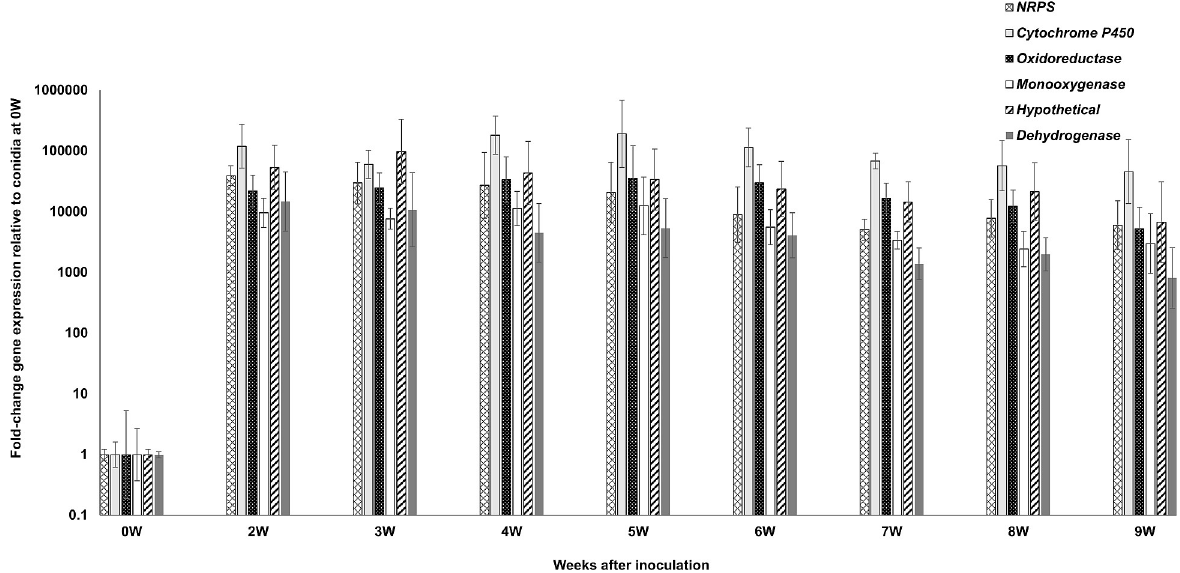
Fig 5. Time course of fold-change gene expression of PKS10-2 cluster genes in wild type P . fijiensis isolate 10CR1-24 in infected banana relative to expression in conidia. PKS10-2 cluster genes assessed include the NRPS, the cytochrome P450, the oxidoreductase, the monooxygenase, a hypothetical gene encoding a protein of unknown function, and the dehydrogenase genes. To determine gene expression, tissue was harvested from infected banana plants at weekly intervals starting at 2 weeks through 9 weeks post-inoculation. Fold-change gene expression is shown relative to the expression at 0 weeks (in conidia) which is set to 1, with error bars indicating standard error from three biological replicates. W = week.